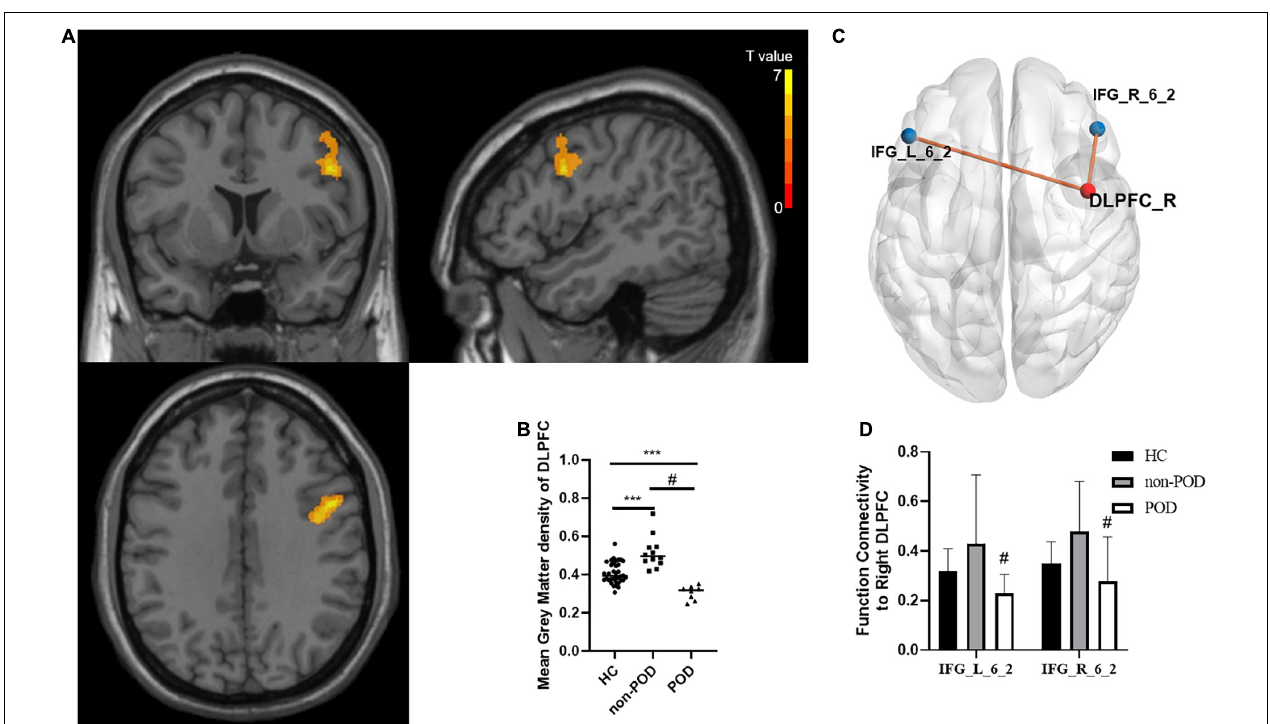
FIGURE 2 | Comparisons of gray matter (GM) volume as well as functional connectivity between healthy controls (HCs) and patients with left frontal lobe glioma with and without delirium. (A) Spatial distribution of the GM volume abnormalities between delirium group and no delirium group. The yellow area presents brain region with significantly increased GM density calculated by voxel-based morphology (VBM) analysis (Voxel size = 1.5 mm 3 , cluster size = 114, Permutation test + TFCE, P < 0.001, Cohen’s d = 2.95). The color bar shows the T value. These samples show enhanced GM volume in the dorsal lateral prefrontal cortex (DLPFC)_R. (B) The comparison of mean GM density in the right DLPFC between HCs, postoperative delirium (POD) group, and non-POD group. Bars show the mean; error bars show the SE. (C) The differences of functional connectivity based on DLPFC_R between the non-POD group and POD group are shown in MNI-152 space with a P -value threshold of 0.01. (D) The comparison of z value of functional connectivity between DLPFC_R and IFG_L _6_2, as well as DLPFC_R and IFG_R _6_2 between HC group, POD group, and non-POD group. *** compared with HC, Mann-Whitney U test, P < 0.01, # compared with non-POD, Mann-Whitney U test, P < 0.01. DLPFC, dorsolateral prefrontal cortex; GM, gray matter; HC, health control; POD, postoperative delirium; R, right; VBM, voxel-based